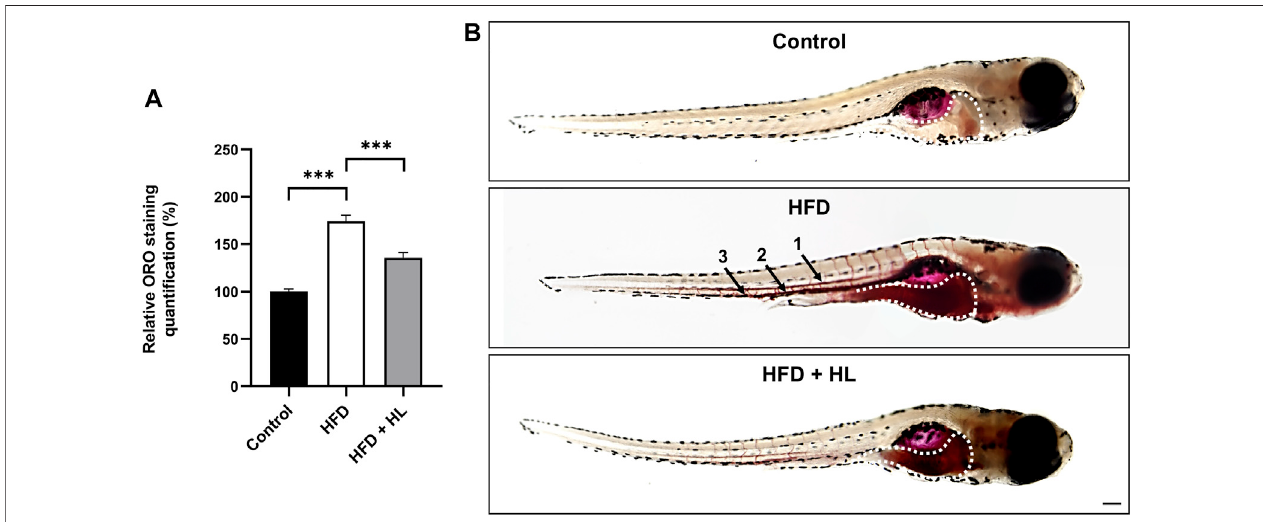
FIGURE10| H.lanceolatum aqueousextractinhibitslipidaccumulationinaHFDmodeloflarvae. (A) Quanti fi cationofOROstainingand (B) representativepictures of normally fed larvae (Control), overfed (HFD) and overfed larvae treated with H. lanceolatum aqueous extract at 0.3125 g/L (HFD + HL). Dotted lines indicate the ORO staining in the digestive tract. Arrows show the staining in vessels including dorsal aorta (1), posterior cardinal vein (2) and caudal vein (3). Results are expressed as means ± SEM ( n = 45 larvae/group from 3 independent experiments). *** p < 0.001 (One-way ANOVA). Bar = 150 µm.